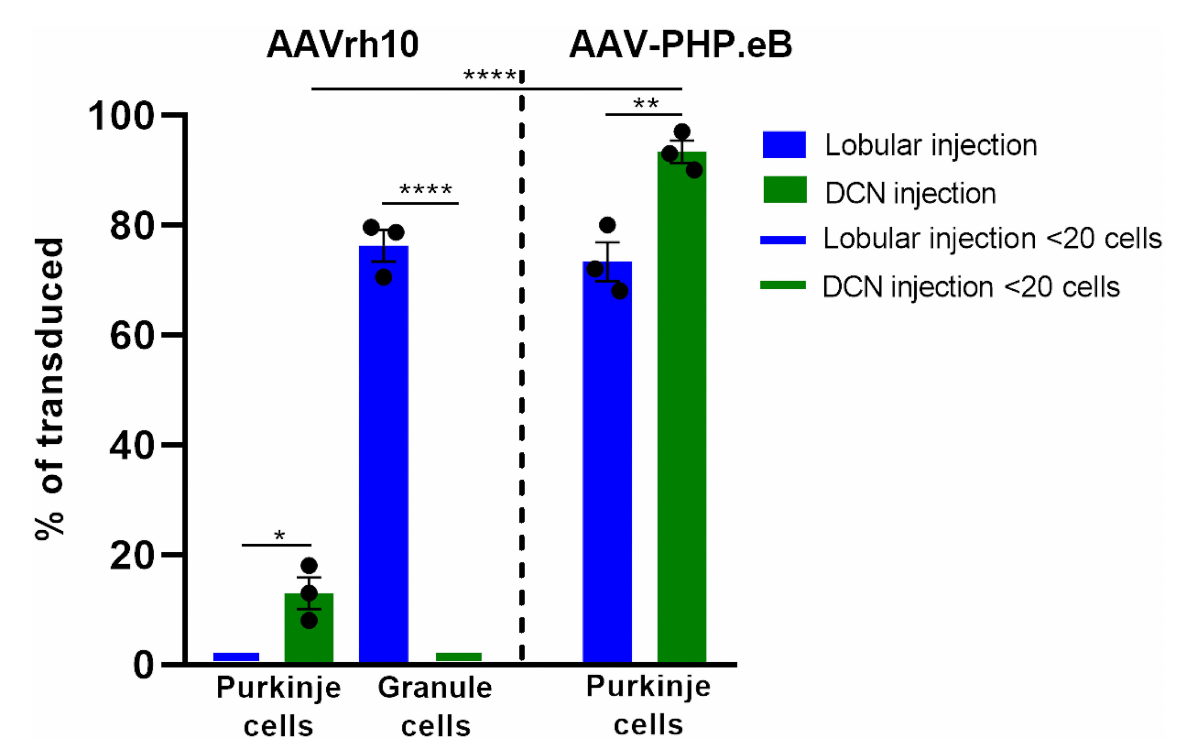
FIGURE8 Histogram summarizing the transduction efficiency of Purkinje cells and granule cells after lobular and DCN injection of AAVrh10-eGFP and AAV-PHP.eB-eGFP. Purkinje cells transduction efficiency after AAVrh10 lobular vs. DCN injections was close to 1% vs. 13%, respectively ( N = 3; difference between means 12% 2.887 SEM; p < 0.0142, *). Granule cell transduction efficiency after AAVrh10 lobular vs. DCN injections was 76% (late stage) vs. close to 1%, respectively ( N = 3; difference between means 75% ± 2.895 SEM; t-test p < 0.0001, ****). Purkinje